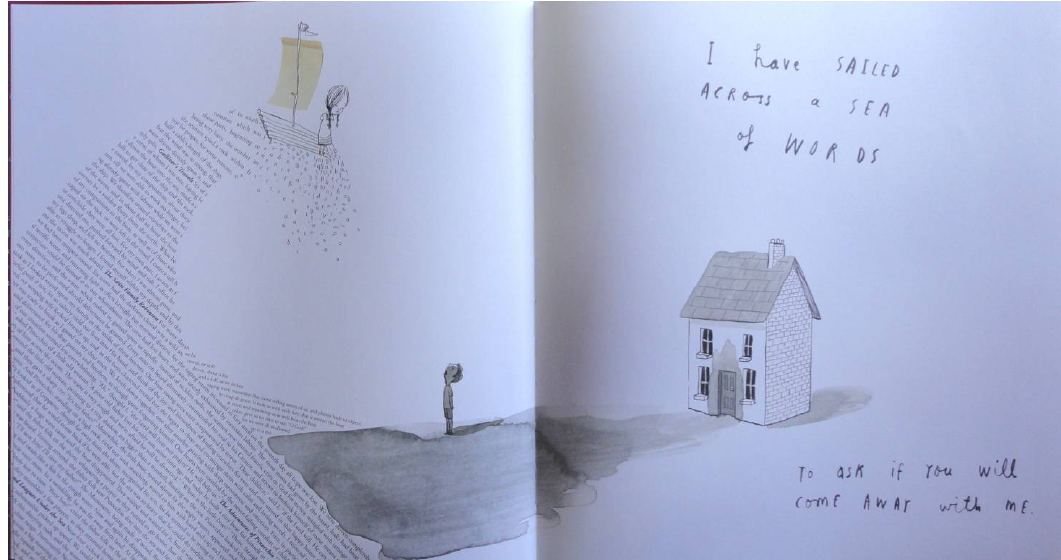
Figure A14. Jeffers O.; Winston S. A child of books, Walker Books, London, 2016.